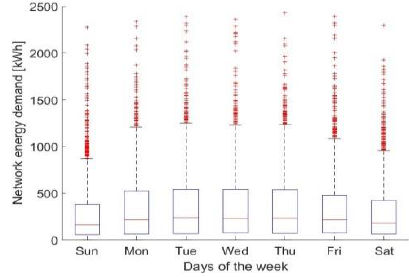
Figure 11. Average energy demand to the network per week day.